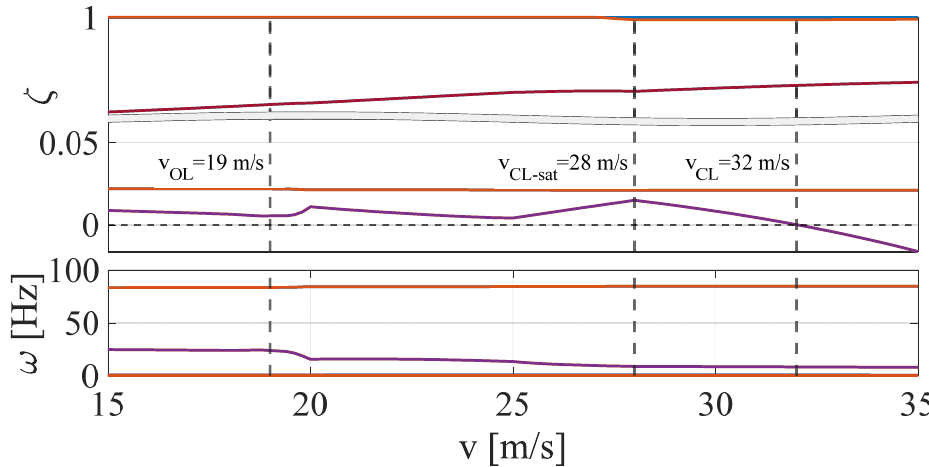
Figure 13. Damping ratio and frequency variations of the closed-loop system.